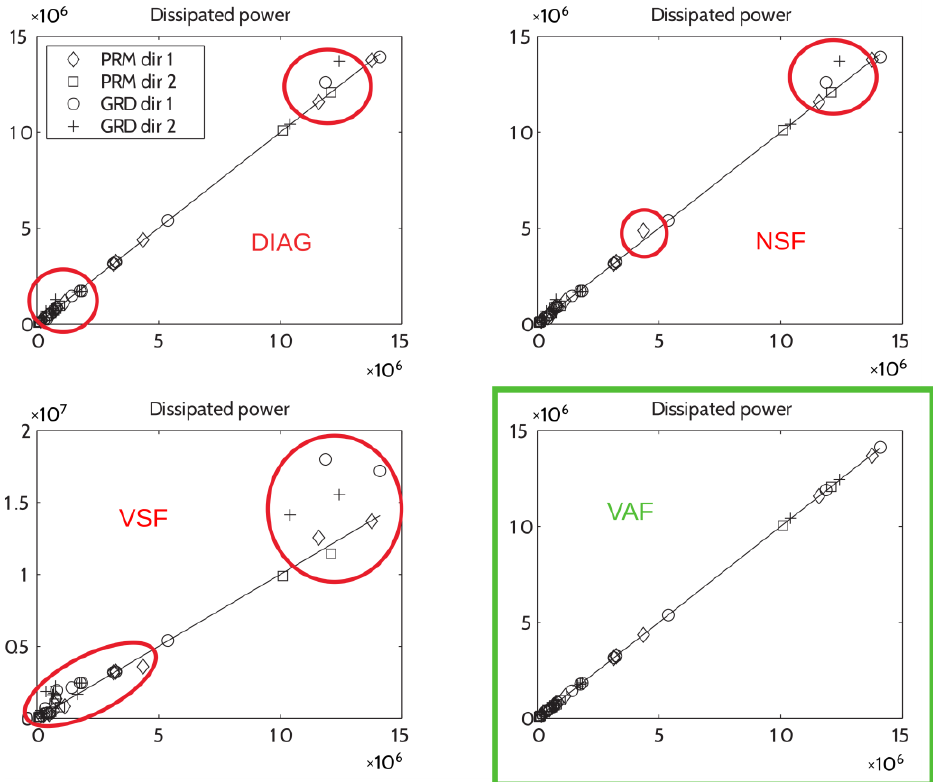
Figure 20. Comparison between the total microscopic dissipated power (P) computed on the heterogeneous media (abscissa) with the total macroscopic power calculated with same boundary conditions on the homogeneous media (ordinate). Only the VAF method with PRM and GRD boundary conditions ensures the equality of the dissipated powers.